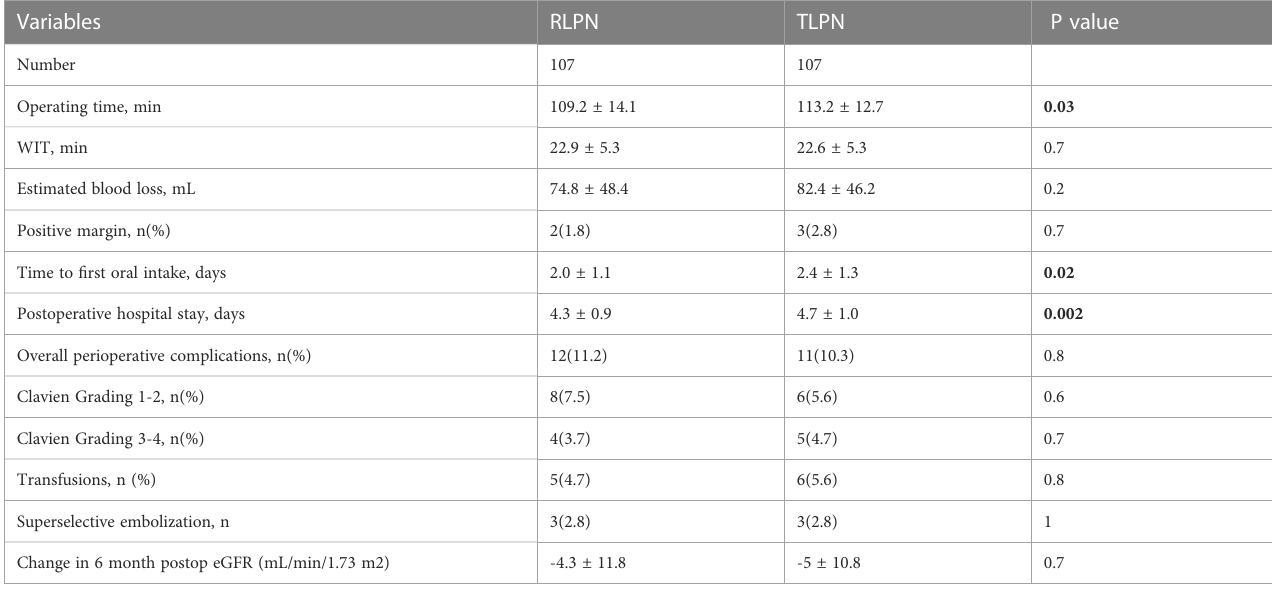
TABLE 2 Perioperative outcomes of patients with RLPN and TLPN. Variables